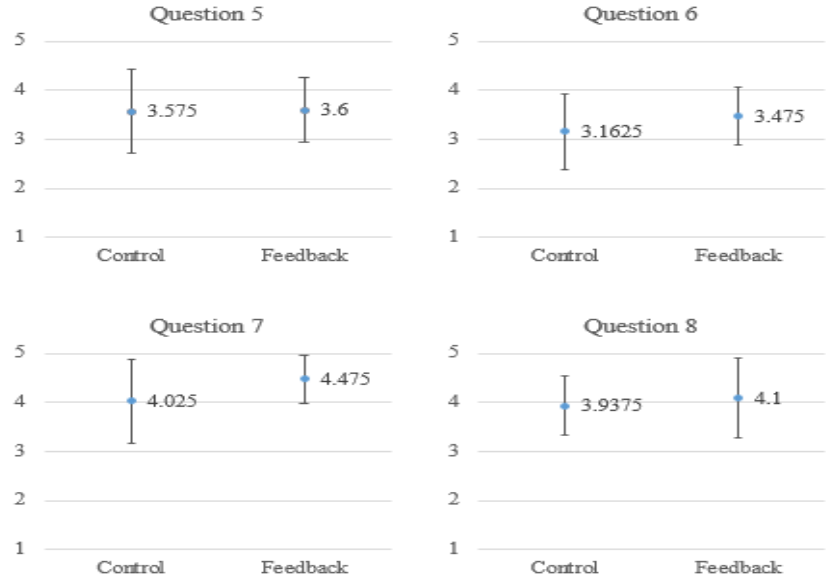
Figure 14. The average point for each item in the questionnaire.